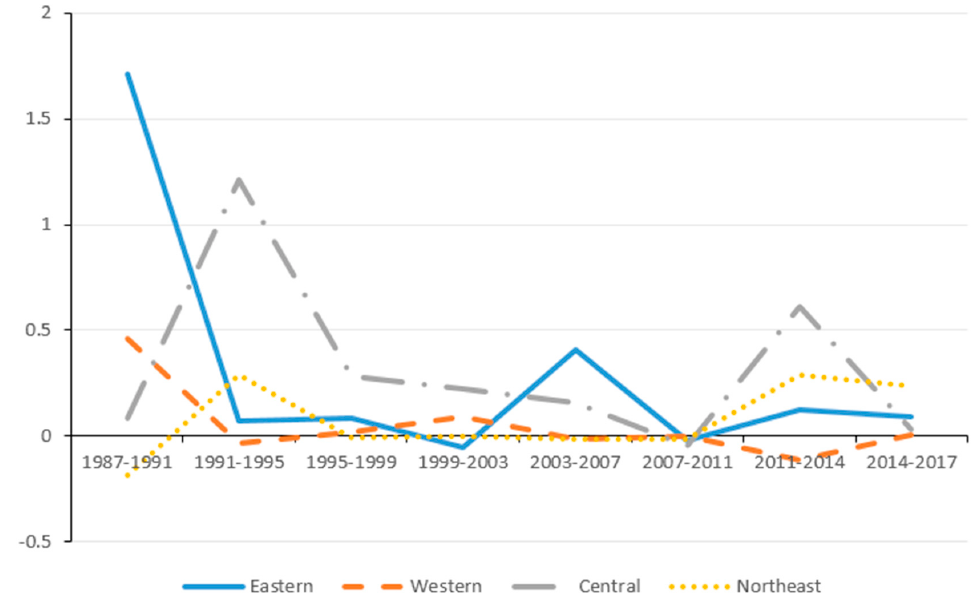
Figure 4. Tendency of the drag effect of water resources in different regions of China.